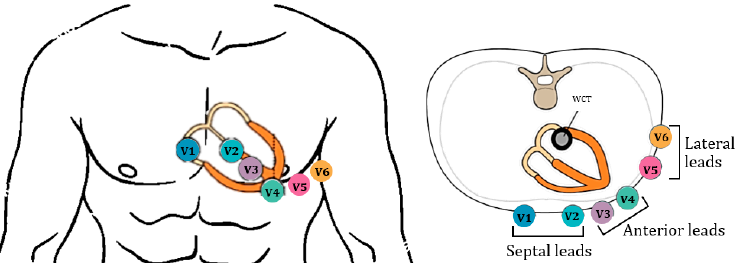
Figure 2. Precordial leads: V1 is placed in the fourth intercostal space. V2 is placed in the fourth intercostal space. V3 is placed in the middle of electrodes V2 and V4. V4 is placed in the fifth intercostal space, on the midclavicular line. V5 is placed on the same line as V4 but on the anterior axillary line. V6 is placed on the same horizontal line as V4 and V5 but on the mid-axillary line.